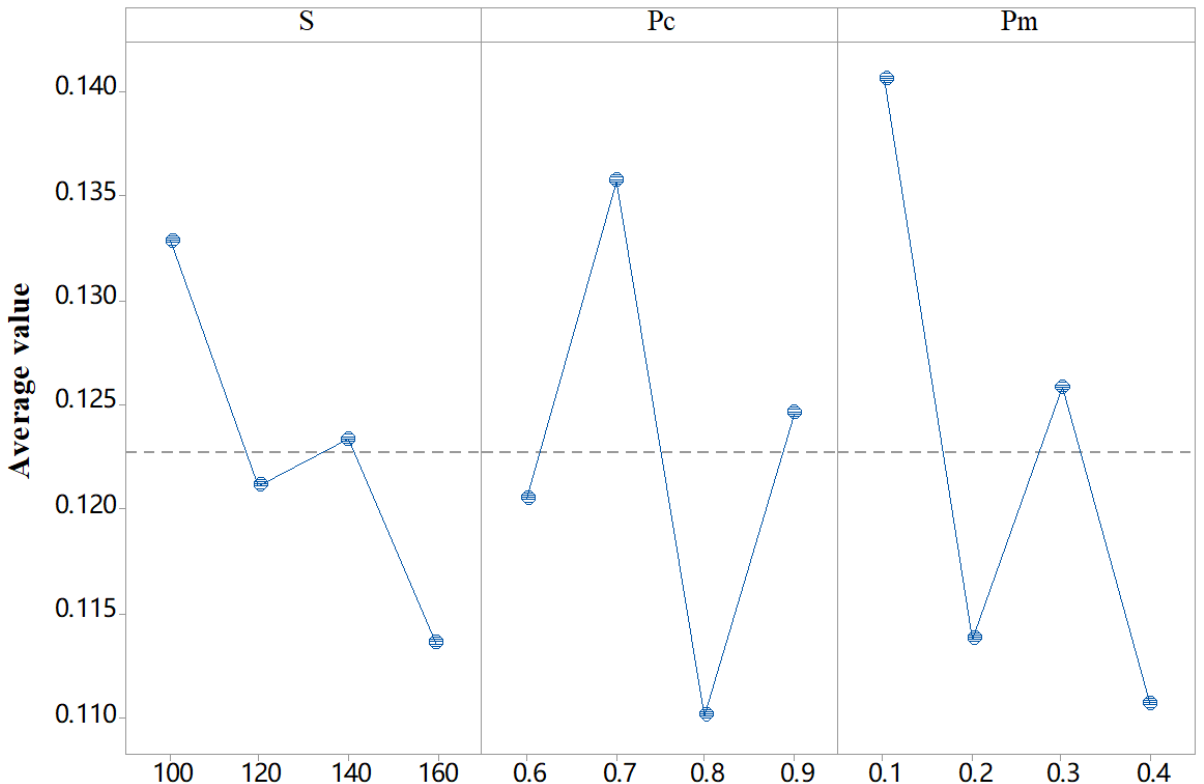
Figure 7. The trend of the factor level for HNSGA-II-VND.